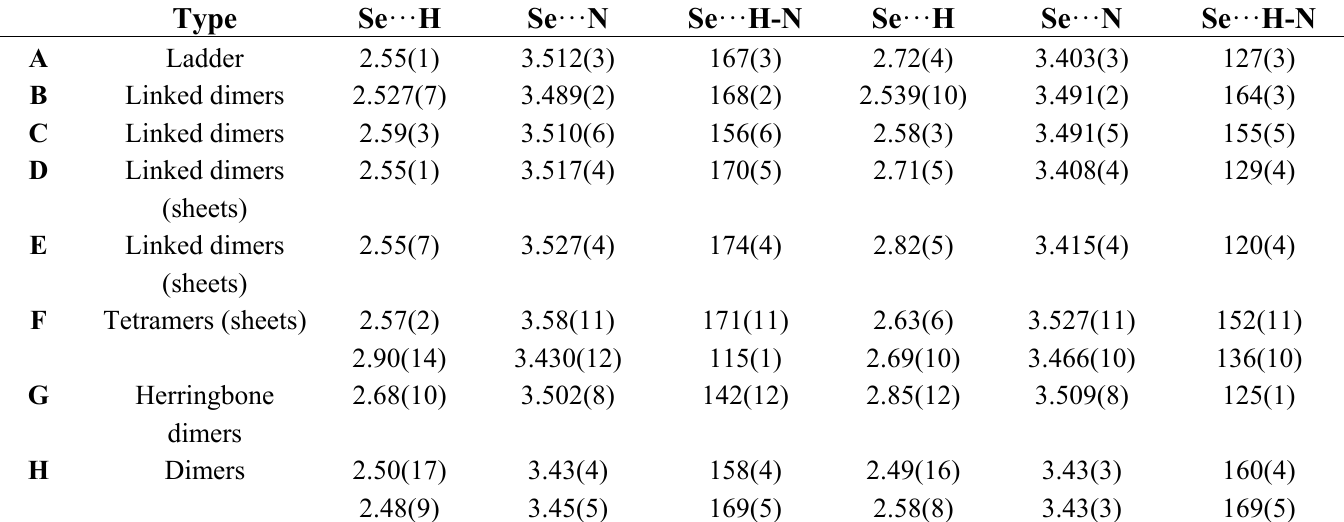
Table 2. Major N-H···Se hydrogen bonding distances